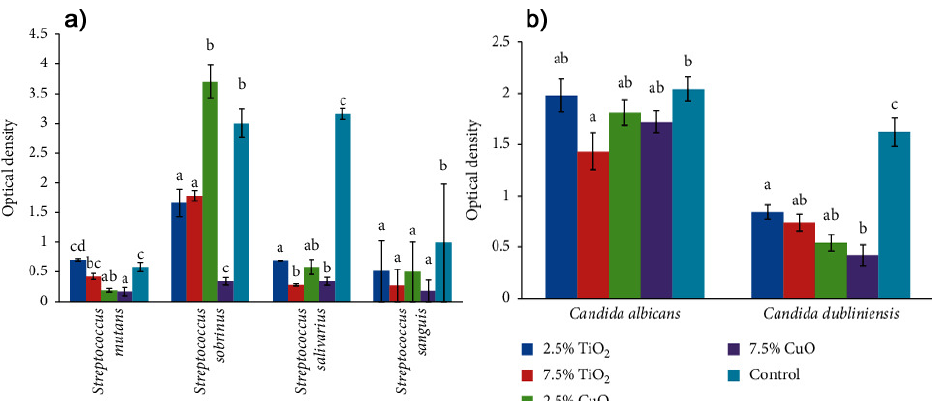
Figure 4. ( a ) Means and standard deviations ( n = 5) of optical density of the study groups against different strains of Streptococcus and ( b ) Candida. Vertically within groups, different superscript lowercase letters indicate significant differences between groups in the same column ( p ≤ 0.05), see Ref. [75] for details. Adapted from Ref. [75].